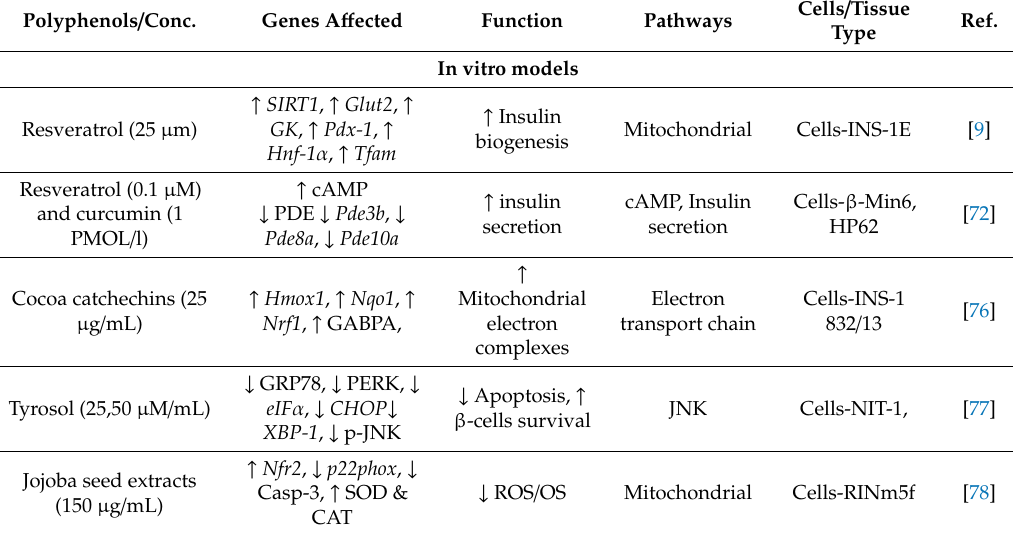
Table 2. Polyphenols and gene modulations on β -cell function pathways. Polyphenols /